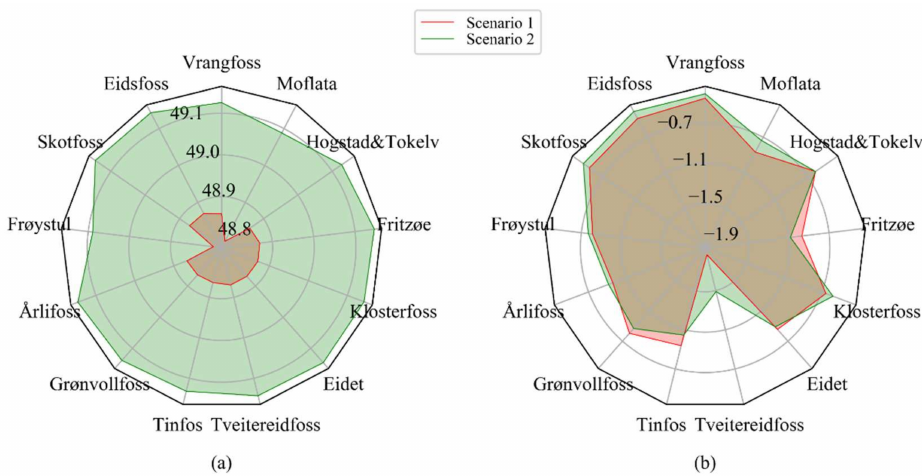
Figure 16. Frequency indicators of the synchronous generator in operation for Scenario 1 and Scenario 2 of the year 2040: ( a ) minimum frequency ( f min ) and ( b ) Maximum